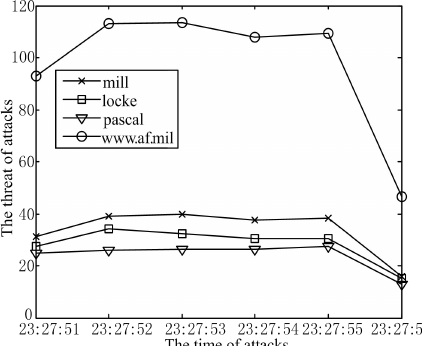
Figure 4: the threat of the different host in fifth period